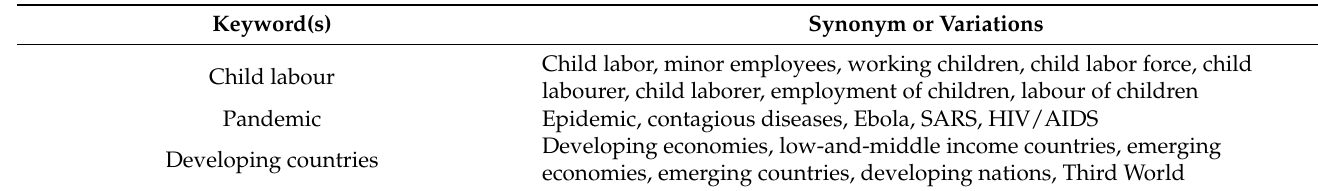
Table 1. Terms and variations of the database research.